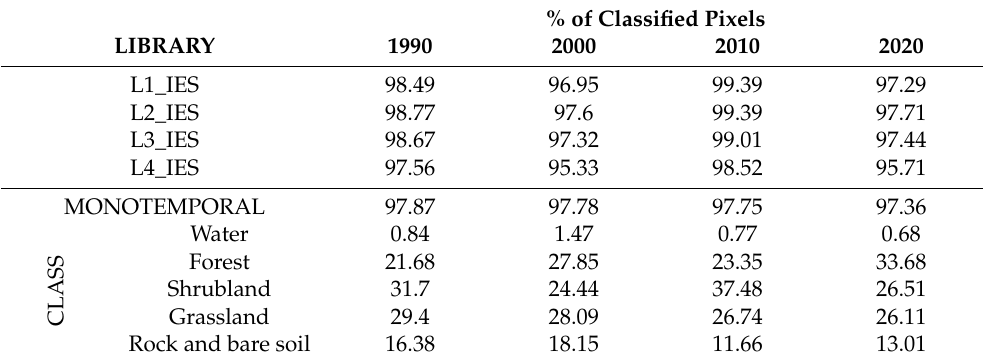
Table 3. Percentage of classified pixels after applying MESMA with the different spectral libraries and the percentage of pixels classified by class according to the MESMA analyses performed with the optimized monotemporal libraries (RMSE ≤ 0.025). % of Classified Pixels LIBRARY